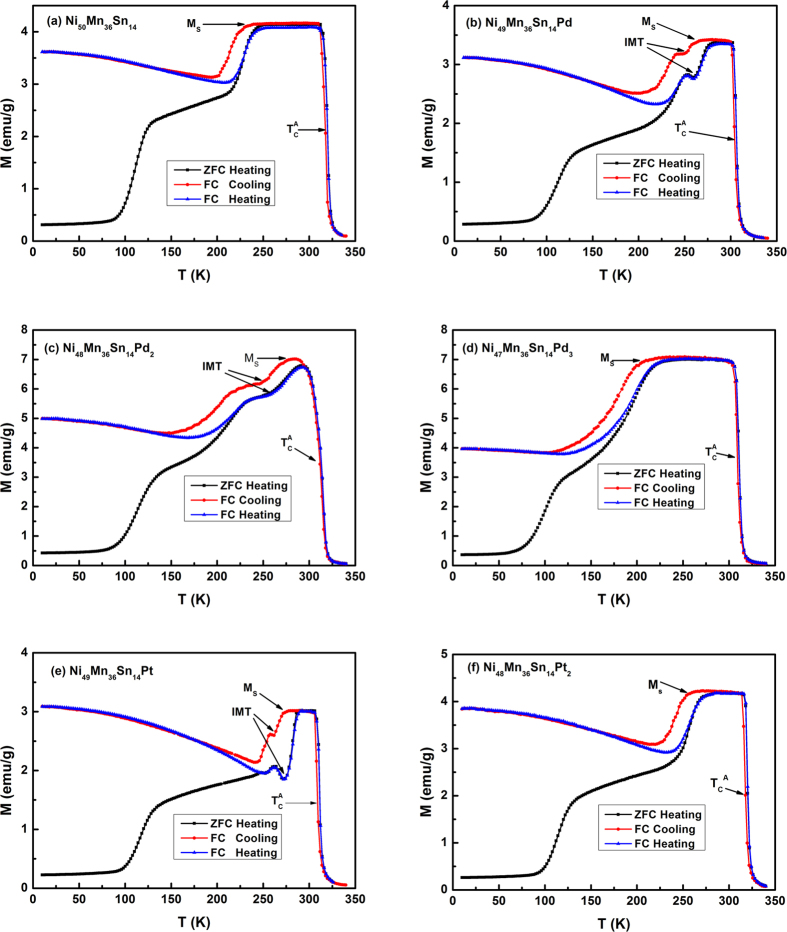
The ZFC, FCC, and FCW M-T curves in the magnetic field of 100 Oe for (a) Ni50Mn36Sn14; (b) Ni49Mn36Sn14Pd; (c) Ni48Mn36Sn14Pd2; (d) Ni47Mn36Sn14Pd3; (e) Ni49Mn36Sn14Pt; (f) Ni48Mn36Sn14Pt2.